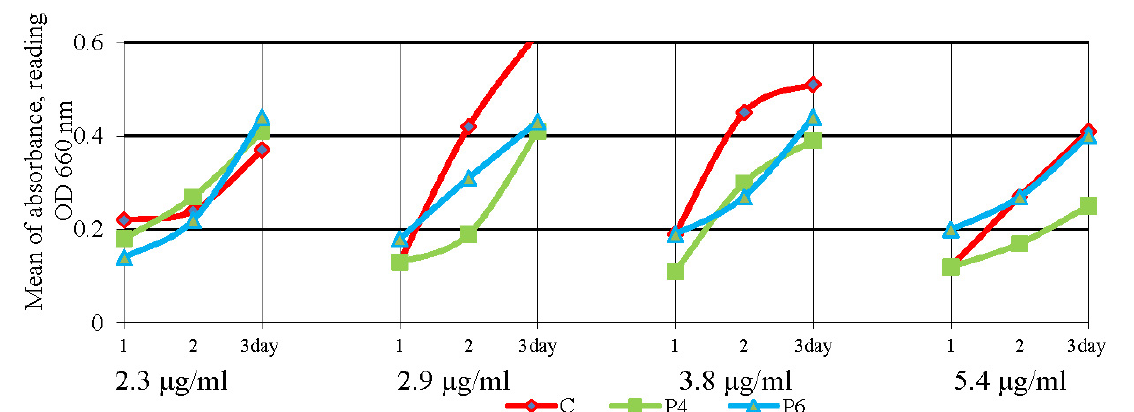
Figure 12. Growth of Pseudomonas aeruginosa ( P. aeruginosa ) under the action of oxytetracycline in complex with polyphosphate ester-type transporters during cultivation in a liquid medium for three days.